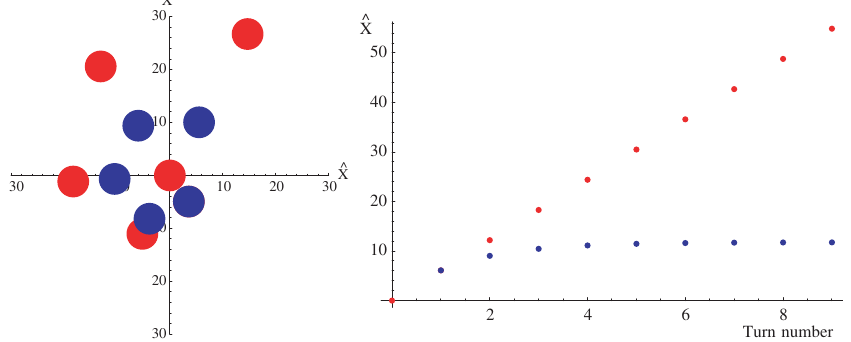
FIG. 11. (Color) Differences between the two models considered for the classical multiturn injection. The position of the injected beams is shown on the left panel (the disk radius represents the three-sigma level of the Gaussian distribution), while the amplitude vs the injected turn is plotted in the right panel. The linear increase of the first model is clearly shown (red markers), as well as the bounded behavior of the second one (blue markers). In all of the cases, the fractional part of the tune is 0 : 17 , while (cid:14)